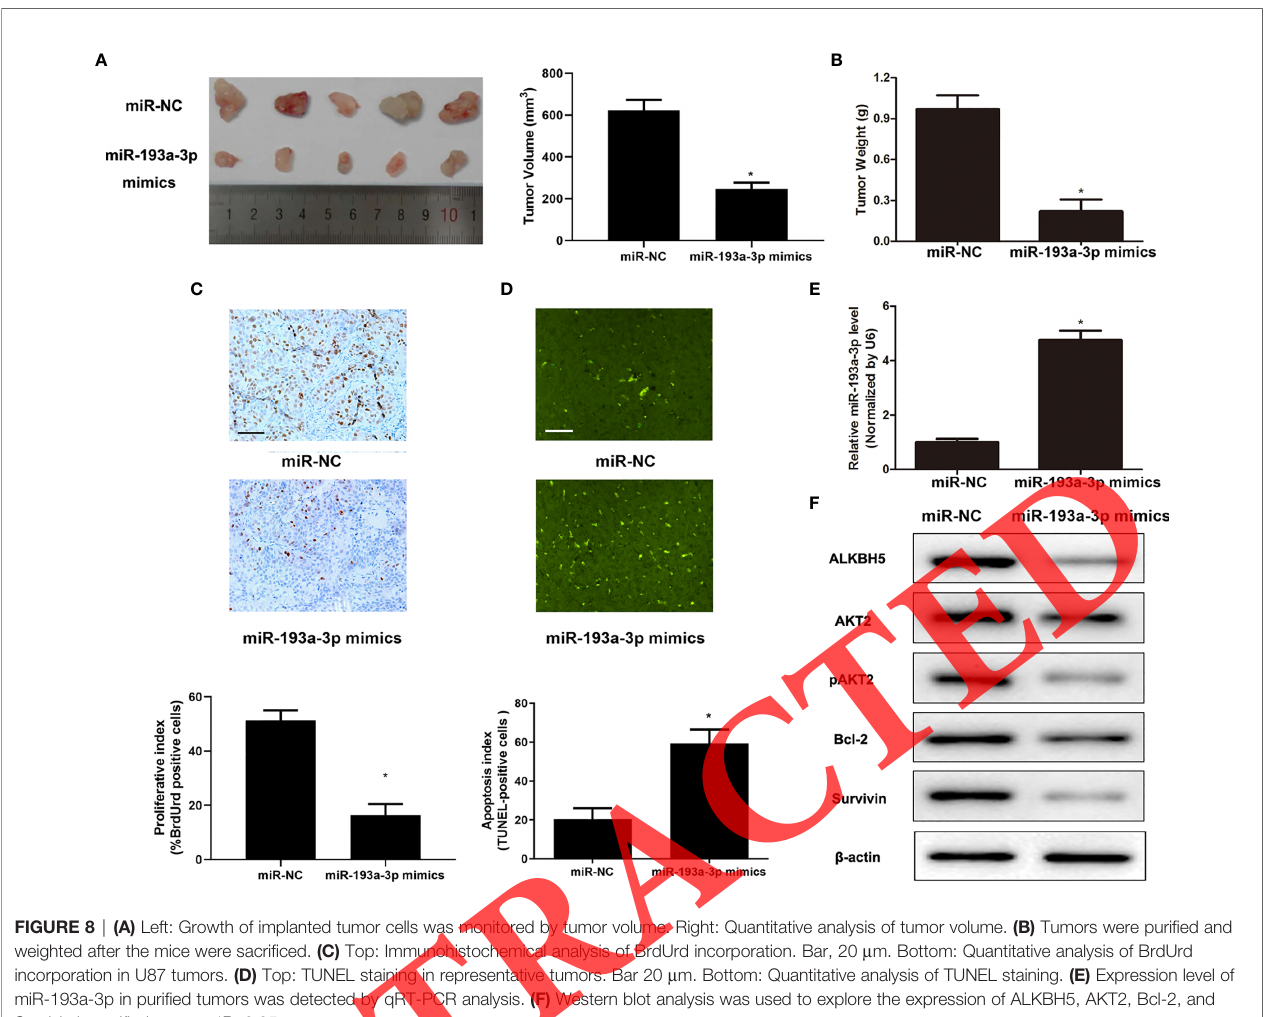
FIGURE 8 | (A) Left: Growth of implanted tumor cells was monitored by tumor volume. Right: Quantitative analysis of tumor volume. (B) Tumors were puri fi ed and weighted after the mice were sacri fi ced. (C) Top: Immunohistochemical analysis of BrdUrd incorporation. Bar, 20 m m. Bottom: Quantitative analysis of BrdUrd incorporation in U87 tumors. (D) Top: TUNEL staining in representative tumors. Bar 20 m m. Bottom: Quantitative analysis of TUNEL staining. (E) Expression level of miR-193a-3p in puri fi ed tumors was detected by qRT-PCR analysis. (F) Western blot analysis was used to explore the expression of ALKBH5, AKT2, Bcl-2, and Survivin in puri fi ed tumors.